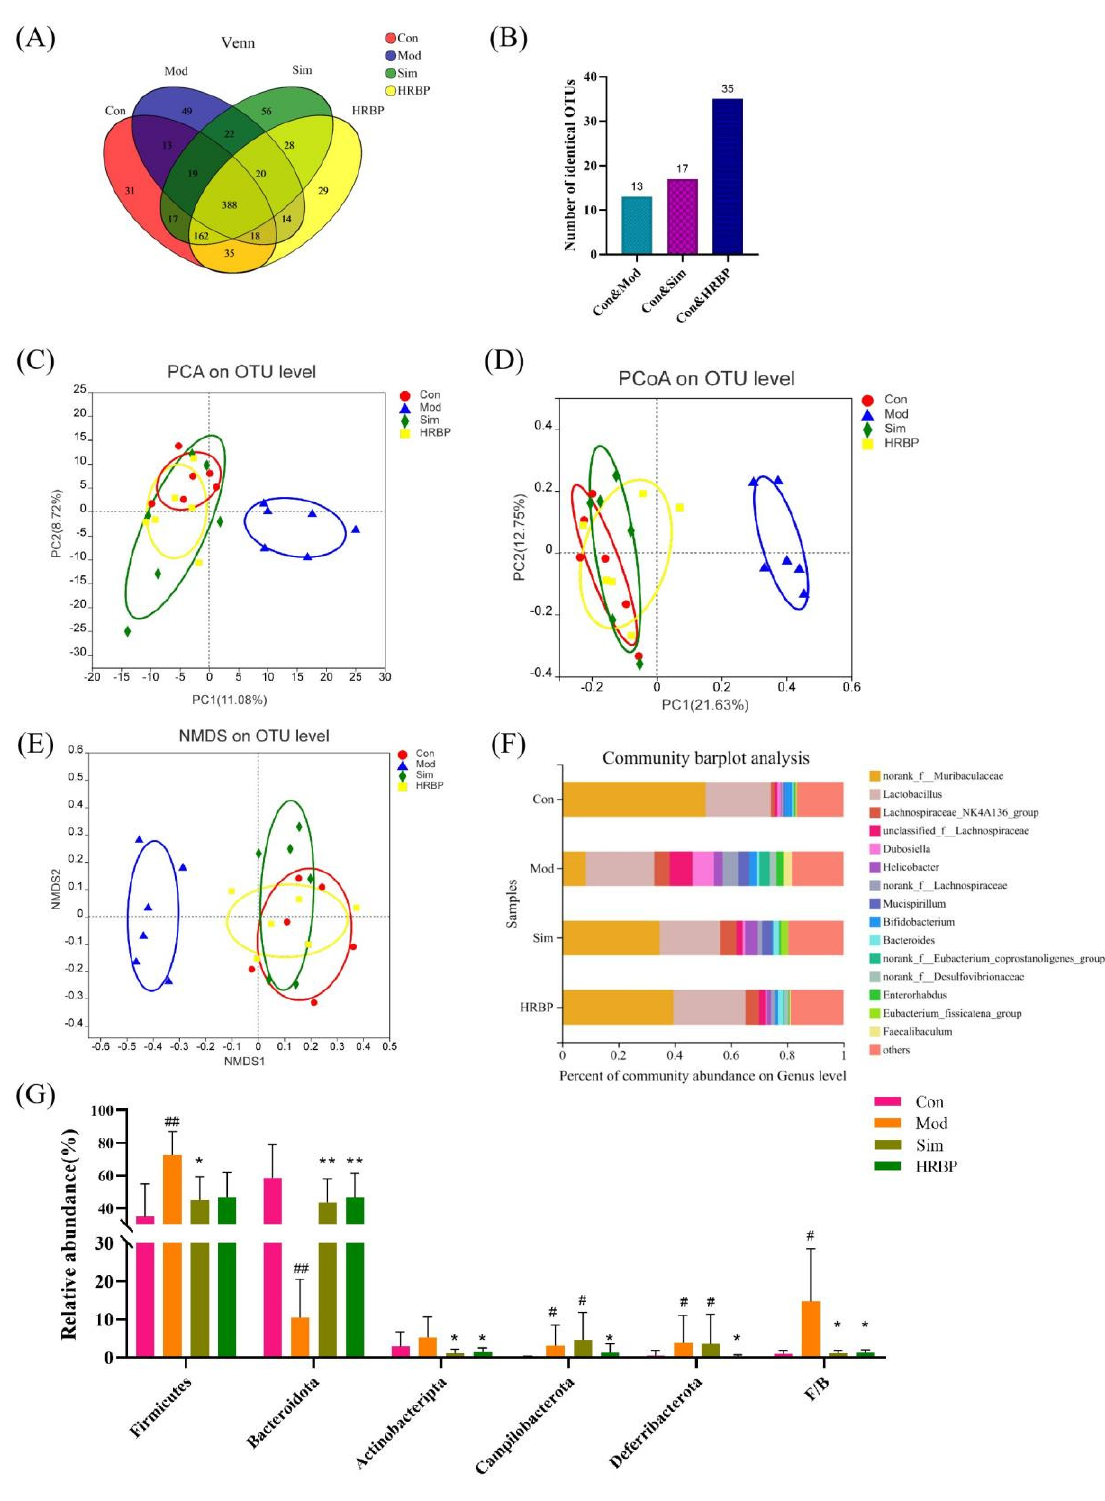
Figure 5. Effect of RBPs on the gut microbiota composition in hyperlipidemic mice. ( A ) Venn diagram. ( B ) Number of OTUs shared by each group and the Con group independently. ( C – E ) The results of beta diversity analysis. ( F ) Composition of the gut microflora at the genus level. ( G ) Relative abundance of the microbiota and F/B ratio at the phylum level. # p < 0.05, ## p < 0.01 compared to Con group, * p < 0.05, ** p < 0.01 compared to Mod group. Con, control group fed with normal diet; Mod, model group fed with HFD; Sim, positive control group fed with HFD and treated with simvastatin; HRBP, high dose RBPs group fed with HFD and treated with 600 mg/kg